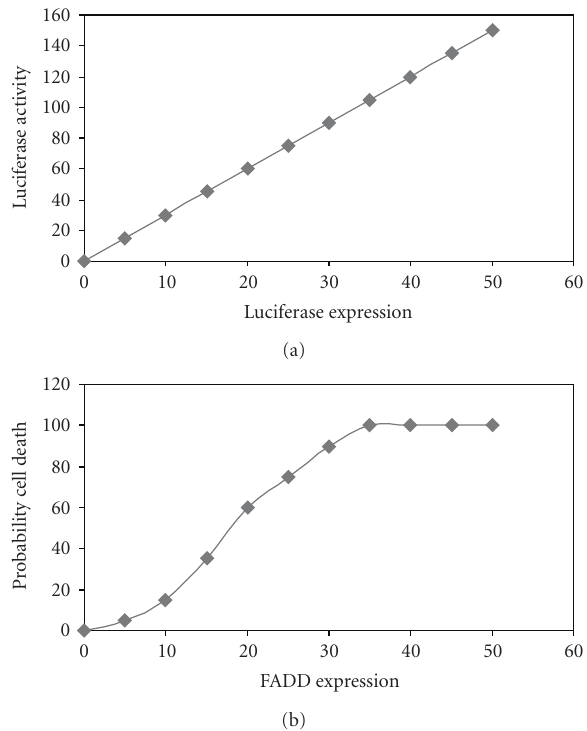
Figure 2: Reporter activity di ff ers from cell death induction. (a) Graph modeling the relationship between luciferase expression and luciferase reporter activity, within the linear range of detection of a luminometer; an essentially linear relationship is depicted. (b) Graph modeling the relationship between concentration of the cell death inducer FADD and probability of cell death for cells in the transfected cell population. An essentially sigmoidal curve is depicted, as the probability of cell death cannot exceed 100% regardless of increasing levels of FADD. For both (a) and (b) arbitrary units of measurement are shown for the purposes of